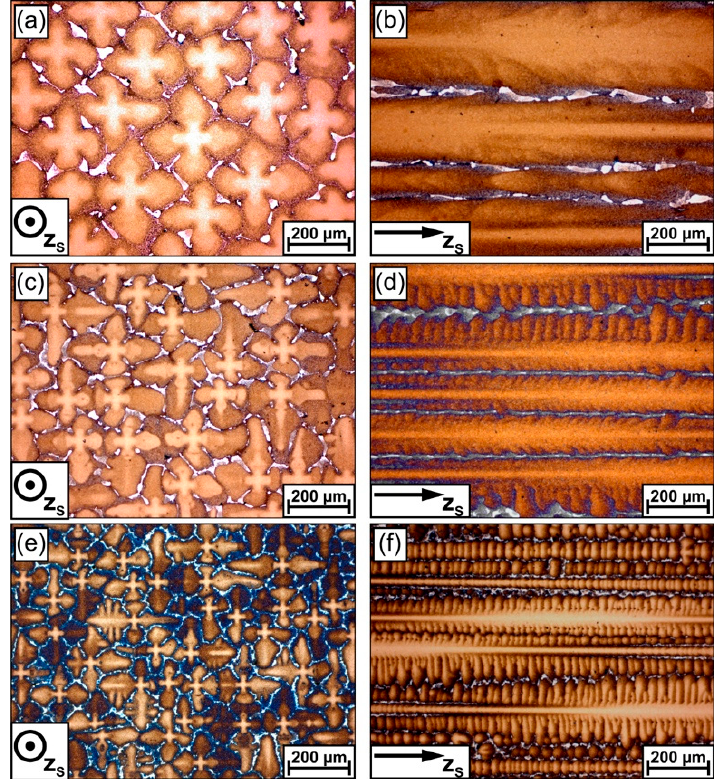
Figure 2. Effect of withdrawal rates on dendritic microstructures. ( a , b ) 45 mm/h; ( c , d ) 180 mm/h; ( e , f ) 720 mm/h. Left column: sections perpendicular to the solidification direction. Right column: sections parallel to the solidification direction.